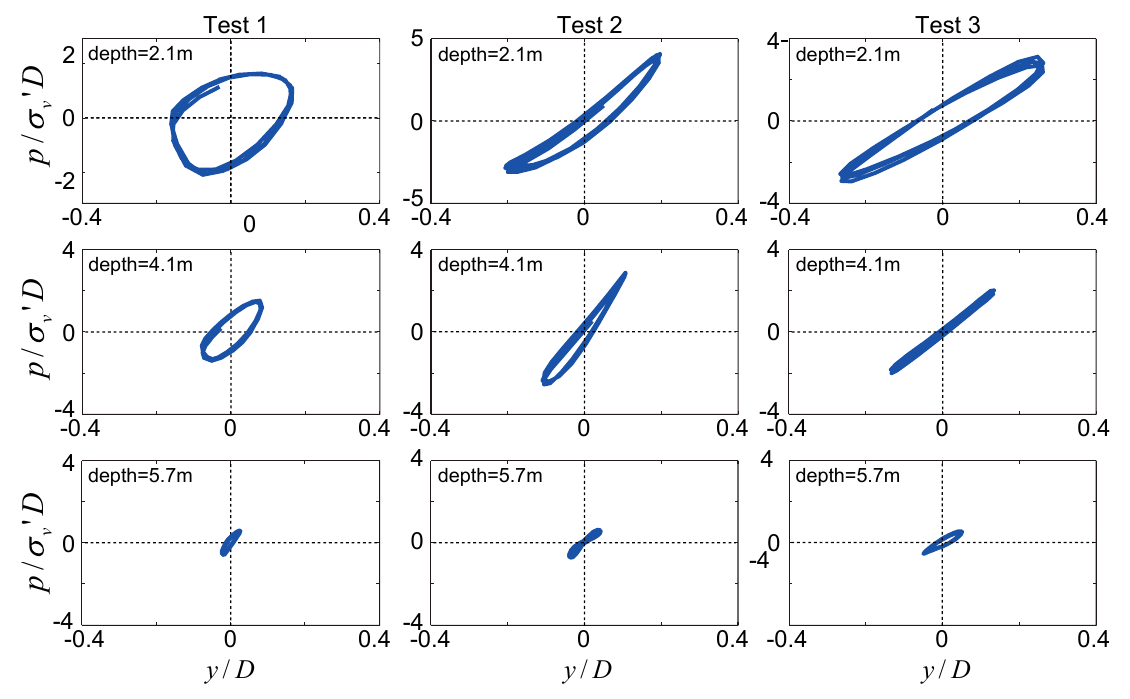
Figure 43. Back-calculated p–y curves from centrifuge tests.